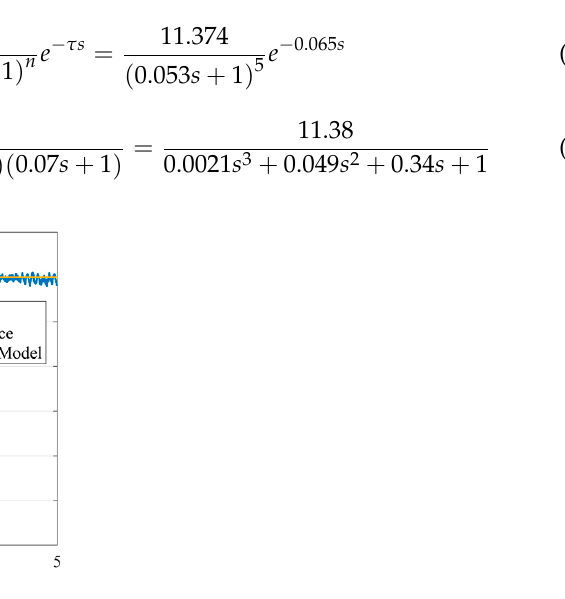
Figure 4. Response validation of the end-e ff ector’s measurement model.